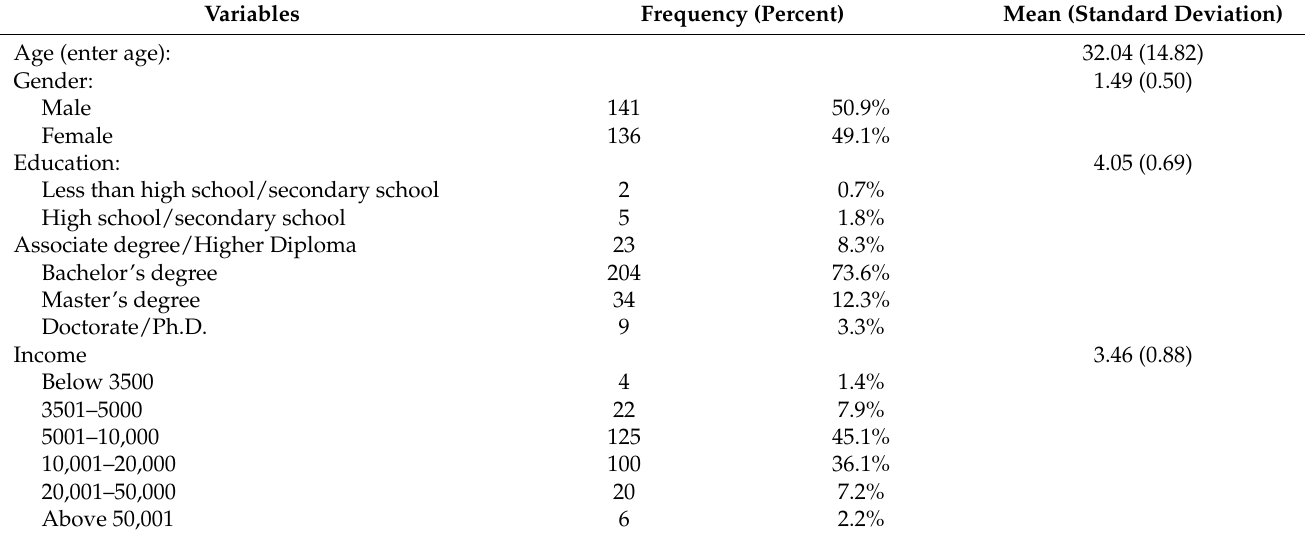
Table 1. Demographic characteristics of respondents (n =